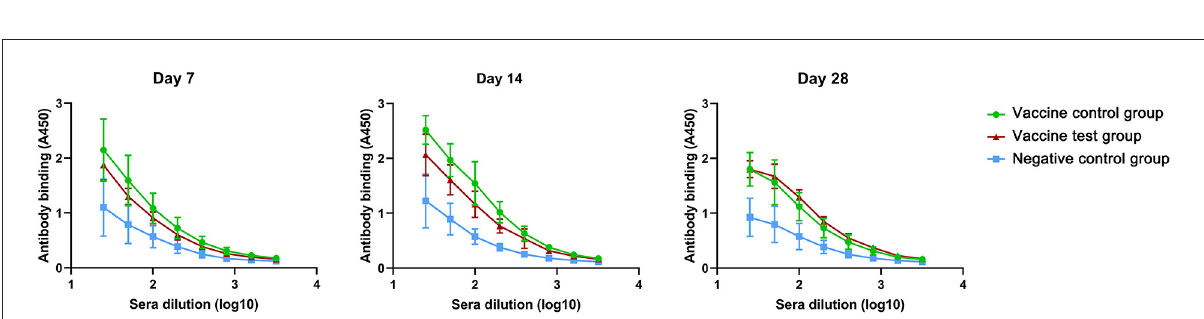
FIGURE2 Anti-spike protein (B.1.617.2) IgM antibody titers in mice serum of three groups at day 7, 14, and 28 (Vaccine test group, n = 4; Vaccine control group, n = 4; Negative control group, n = 4.).